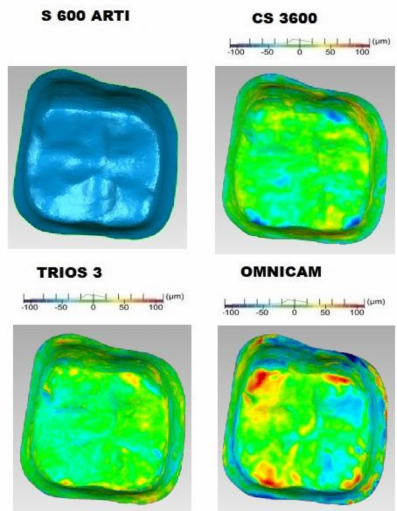
Figure 6. Three-dimensional (3D) Comparison of complete preparation in OVA rendering S600ARTI and 3D comparison analysis for IOS without saliva in relation to the sample 2. Nominal histogram settings ± 25 microns and critical ± 100